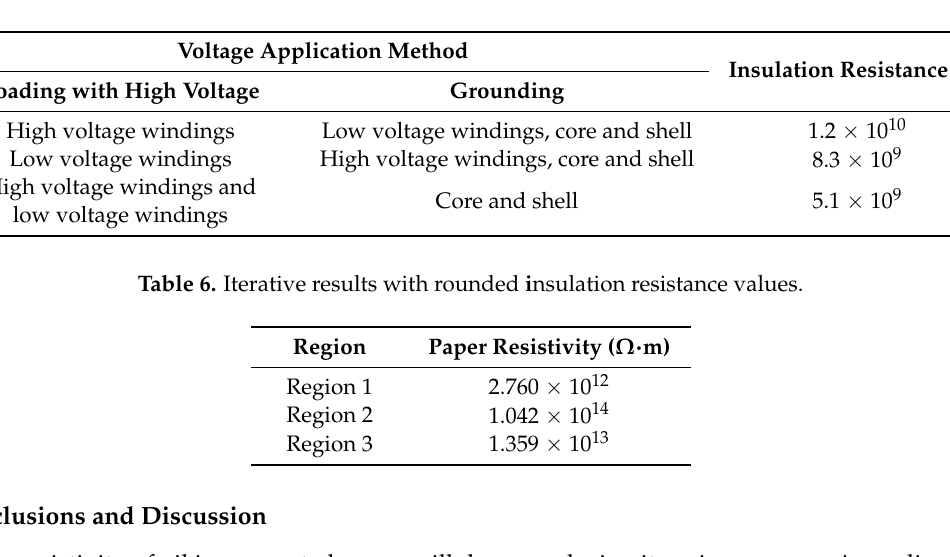
Table 5. Rounded i nsulation resistance values.